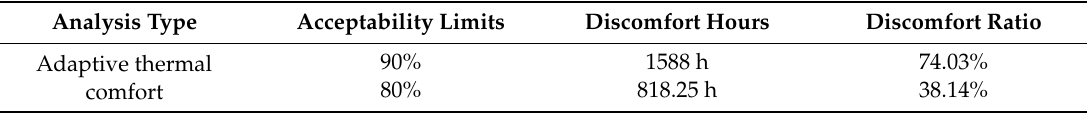
Table 7. Comfort analysis of the base-case building.